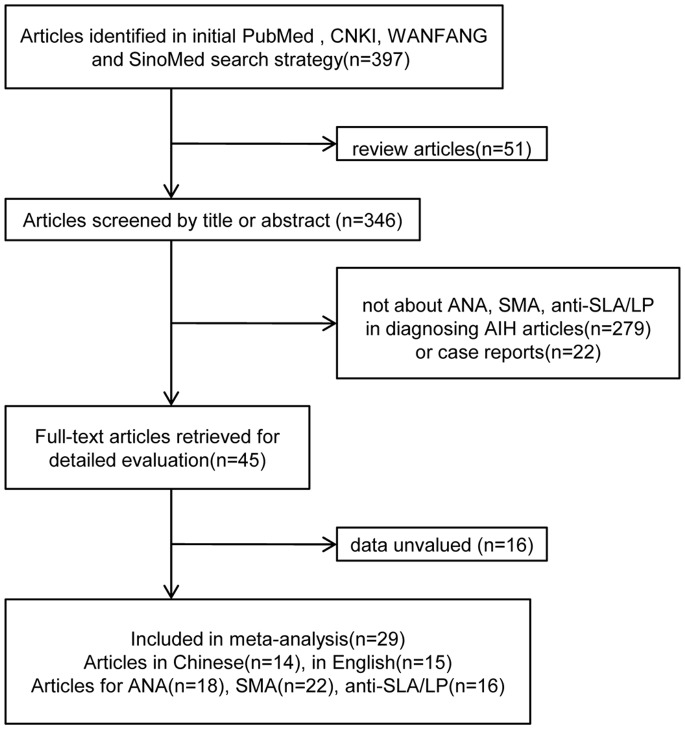
Study flow diagram.